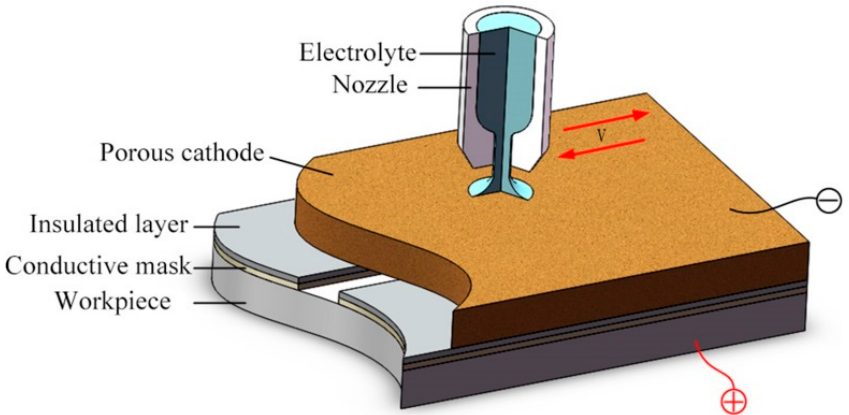
Figure 1. The schematic diagram of jet machining with a conductive masked porous cathode.